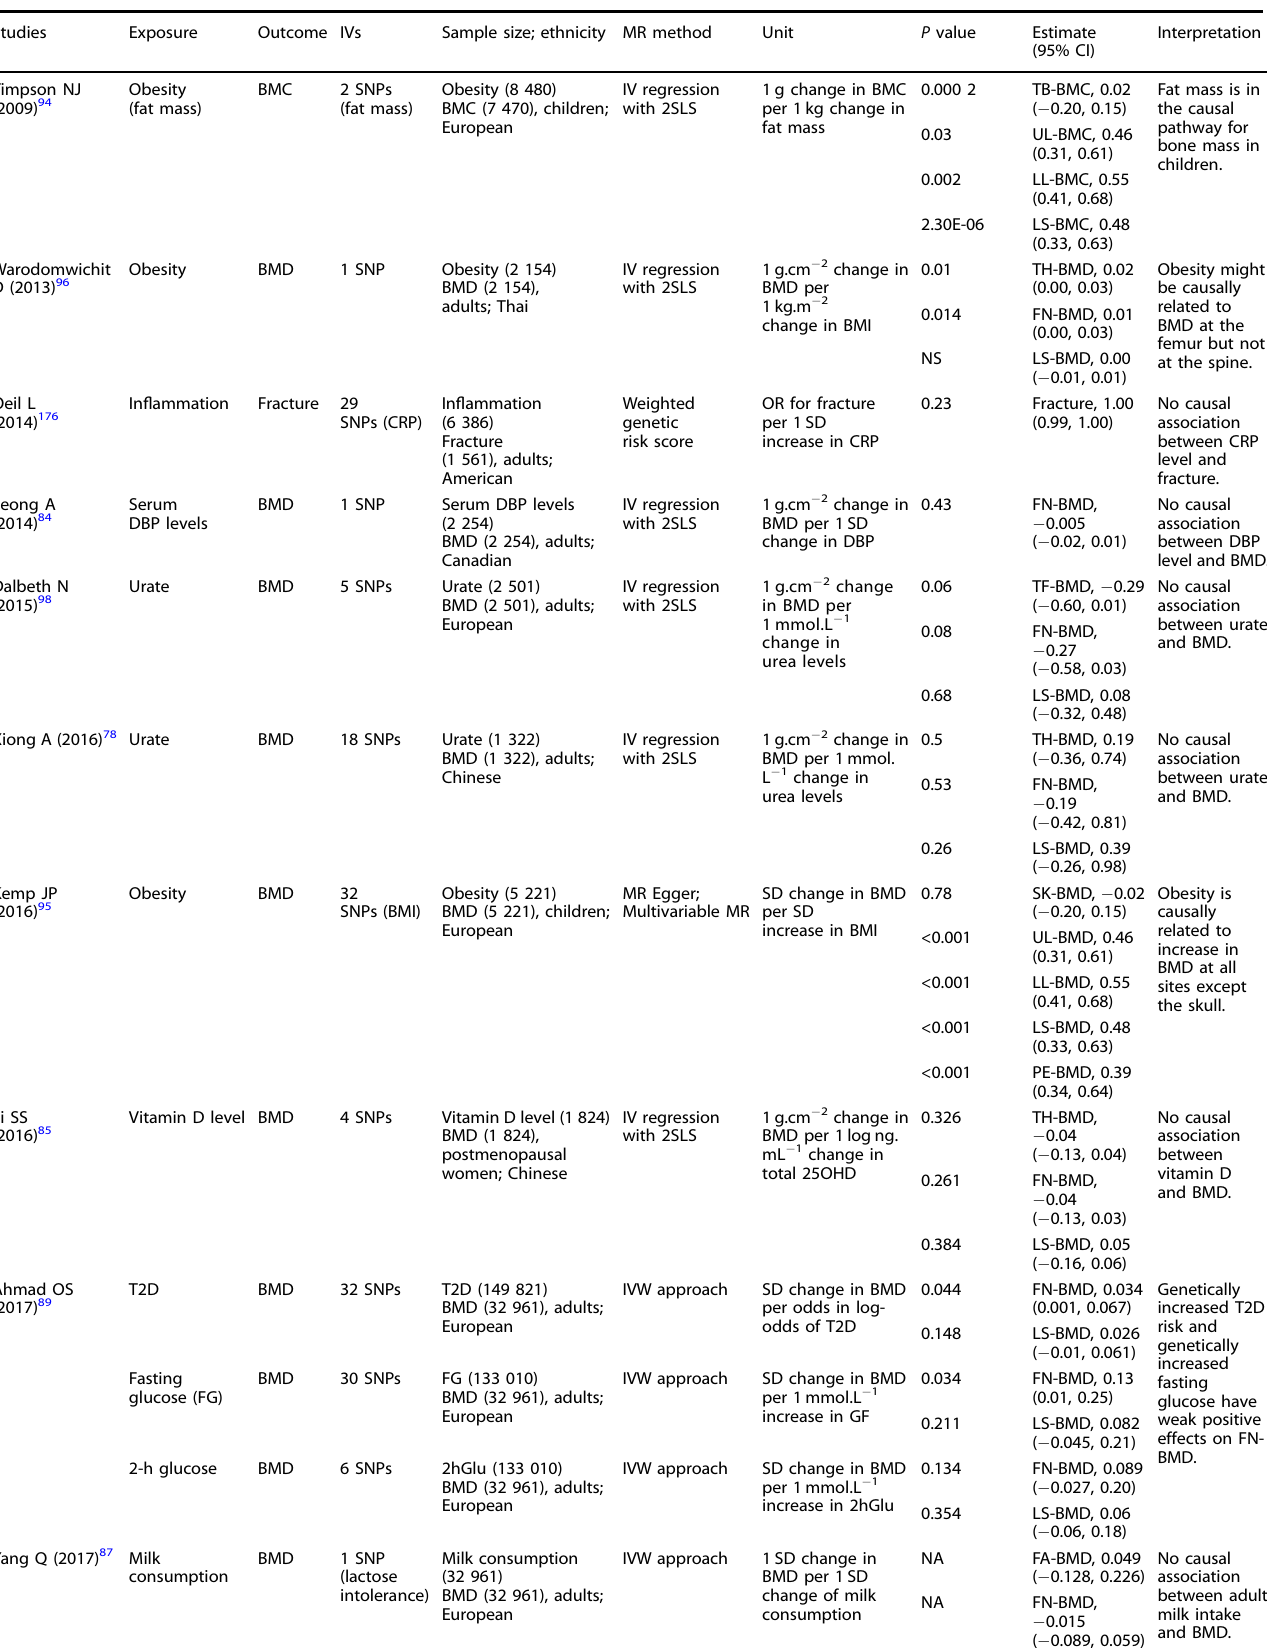
Table 2. Mendelian randomization studies in the bone fi eld